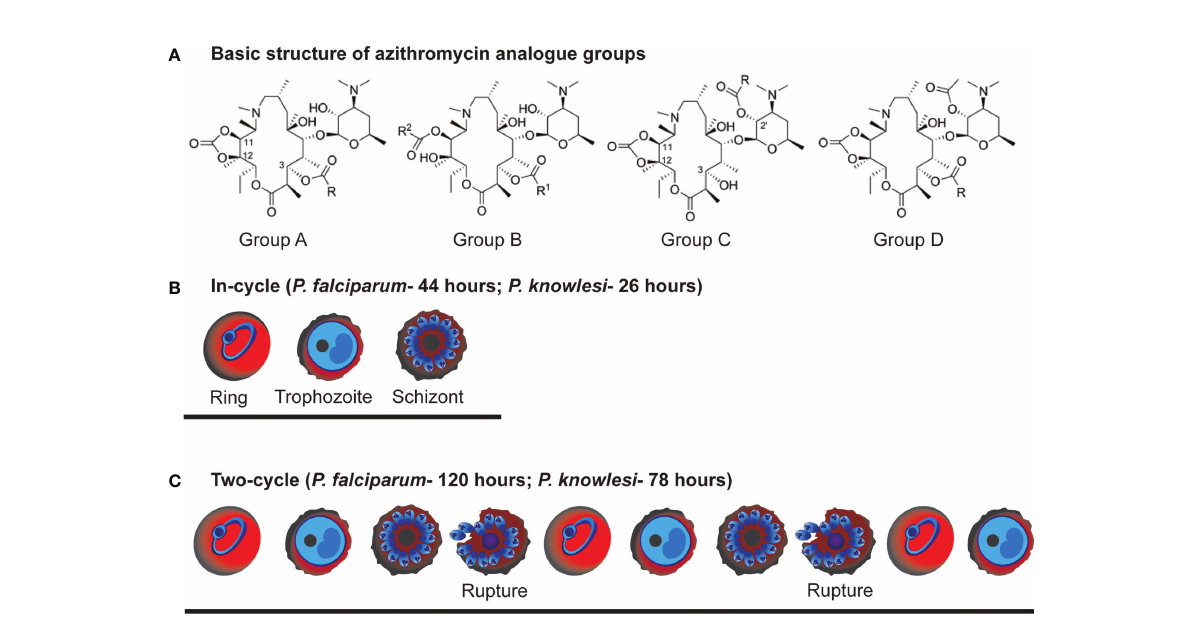
FIGURE 1 Azithromycin analogue groups and example stage progression of In-cycle and 2-cycle assays used in the study. (A) Basic chemical structure of the azithromycin analogue groups characterised for their antimalarial activity in this study. (B) In-cycle: early-ring stage parasites (0-4 hrs post- invasion) were drug treated and the resulting parasite growth measured at late schizont stage (44 hrs post-invasion for P. falciparum and 26 hrs for P. knowlesi ). (C) early-ring stage parasites (0-4 hrs post-invasion) were drug treated and the resulting parasite growth measured at late schizont stage after 2 rupture cycles (120 hrs post-invasion for P. falciparum and 78 hrs for P. knowlesi